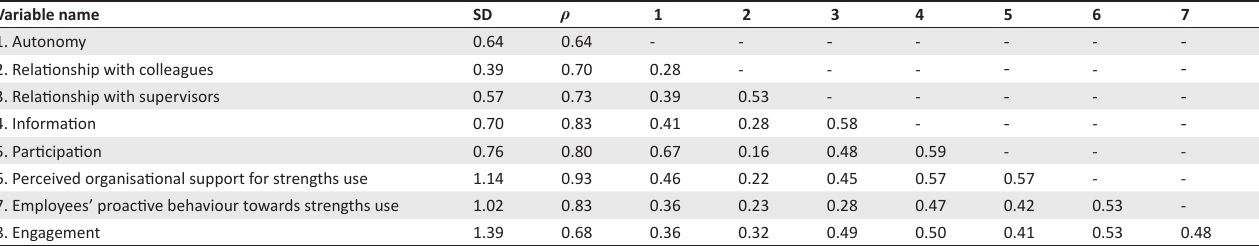
TABLE 3: Correlation matrix (r) and descriptive statistics of the latent variables. Variable name